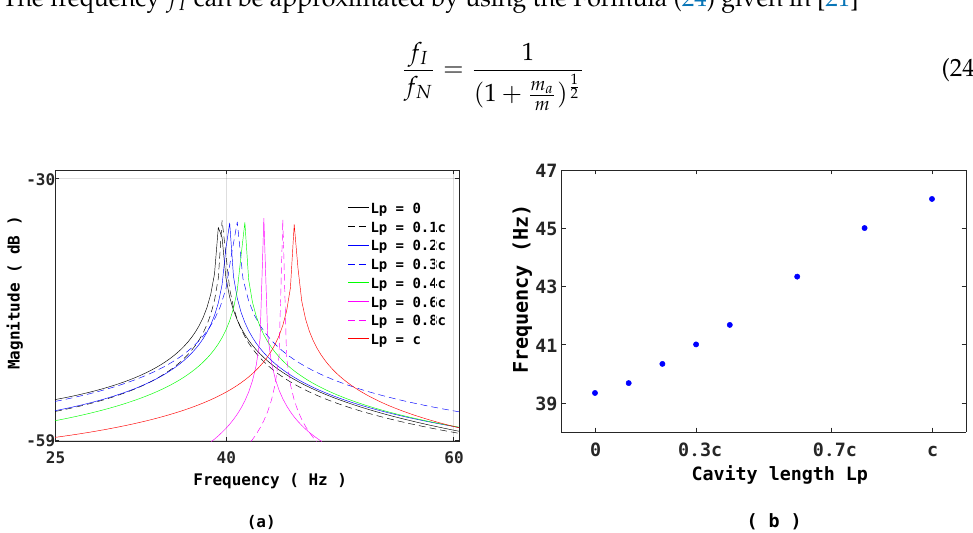
Figure 6. ( a ) Spectrum of hydrofoil movement ξ y for different values of L p . ( b ) Frequency of ξ y versus L p